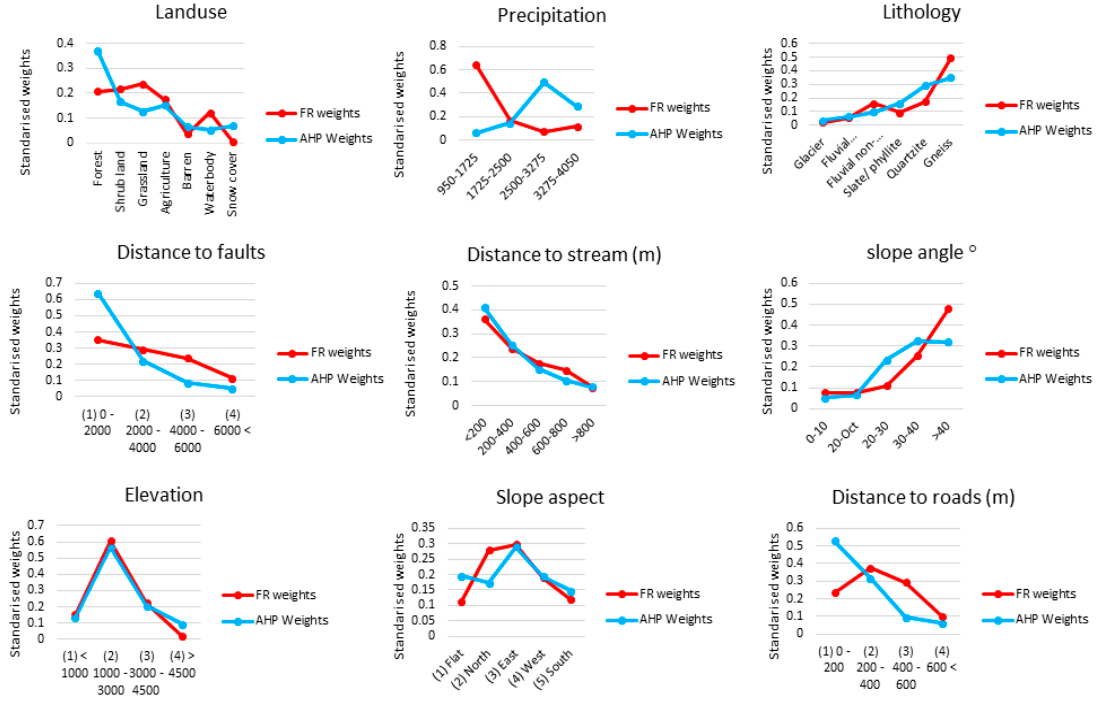
Figure 8. The comparison of the resulting weights for the classes of each factor based on the FR and AHP model.